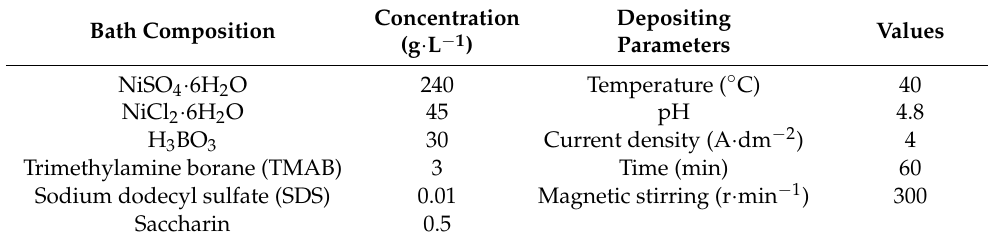
Table 1. Composition of the Ni-B electrolyte and deposition parameters [33]. Bath